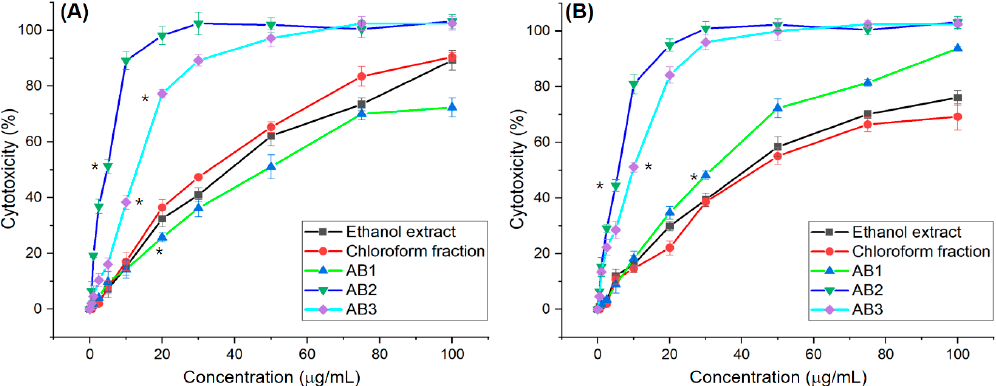
Figure 2. Cytotoxicity of extract, fraction, and compounds on NCI-H460 ( A ) and HepG2 ( B ) cells at di ff erent concentration, * mean significant di ff erence ( p < 0.05) compared to control.